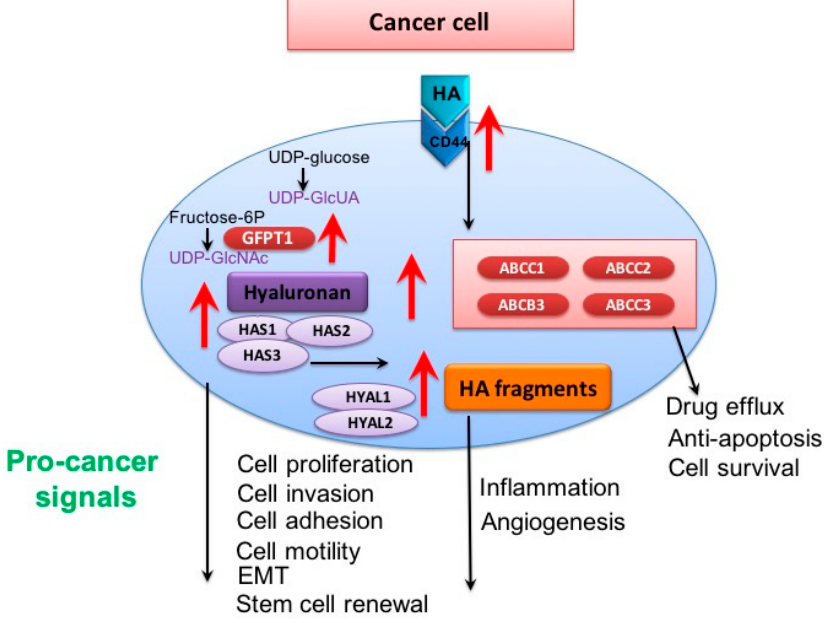
Figure 1. Cancer cells produce increased levels of endogenous hyaluronan (HA) which is